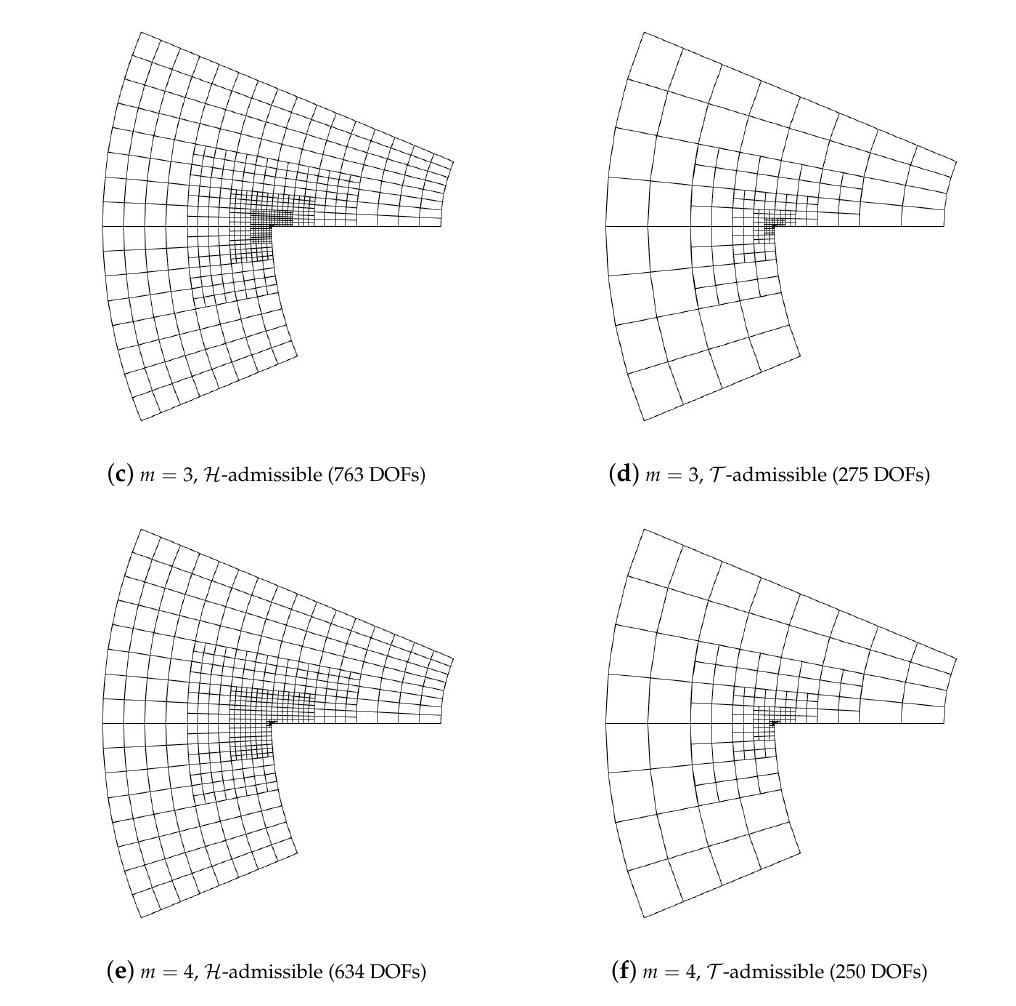
Figure 10. Hierarchical meshes obtained with p = ( 3,3 ) and m = 2,3,4 (from top to bottom ), by using H -admissible ( left ) and T -admissible ( right ) meshes.